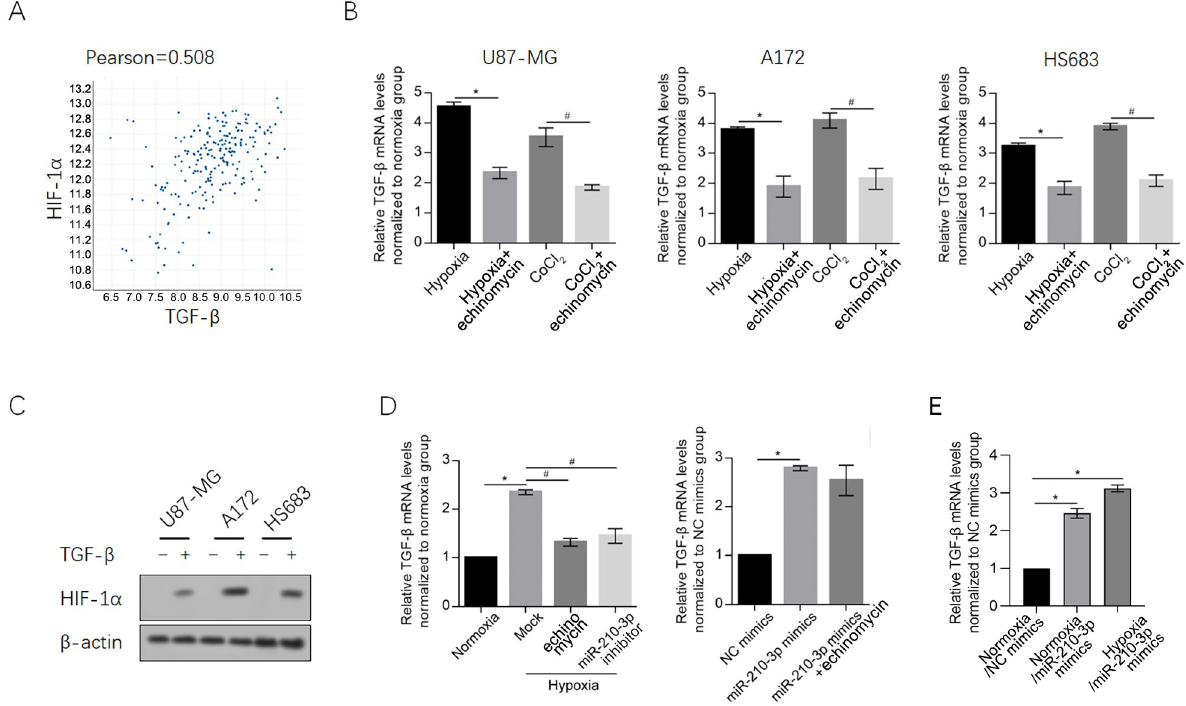
Fig 3. HIF-1 α transcriptionally upregulated TGF- β in glioma cells. A. The correlation of HIF-1 α expression with TGF- β . Data were analyzed using the REMBRANDT database. Increased HIF-1 α expression levels were associated with increased expression levels of TGF- β . B. The expressing levels of TGF- β is detected after hypoxia was detected by RT-qPCR. � P < 0.05, vs. hypoxia group; # P < 0.05, vs. CoCl 2 group. C. HIF-1 α was semi- quantitatively measured by western blot after TGF- β exposure. � P < 0.05, vs. normoxia group; # P < 0.05, vs. hypoxia group. D. After introduction of miR-210-3p mimics or inhibitor, the mRNA levels of TGF- β are detected by RT-qPCR. � P < 0.05, vs. NC mimics group. E. After hypoxia exposure with or without miR-210-3p mimics introduction, the mRNA levels of TGF- β are detected by RT-qPCR. � P < 0.05, vs. NC mimics group.